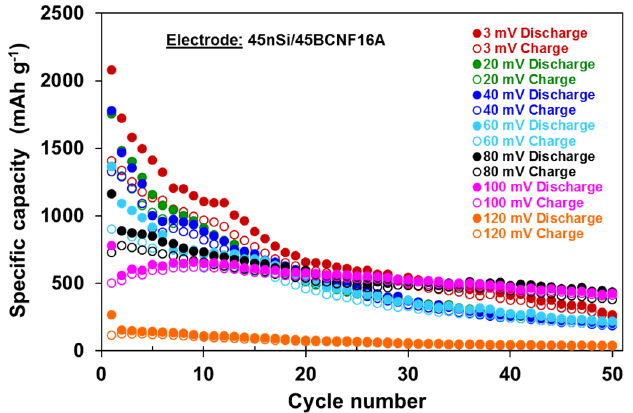
Figure 4. Specific discharge / charge capacity against cycle number plots from the galvanostatic cycling vs. Li / Li + at 100 mA g − 1 of 45nSi / 45BCNF16A electrode, in the 0.9 V to X mV potential range. X = lower cutoff voltage (LCOV).